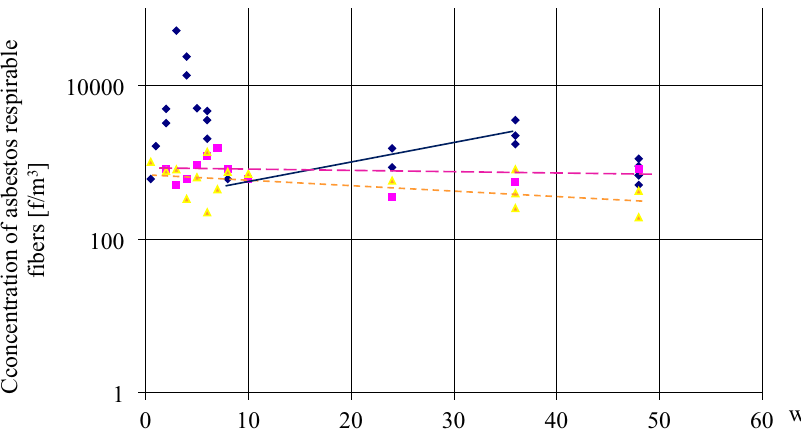
Figure 4. Changes in air pollution of three buildings “LIPSK” within 48 weeks. Dark blue diamond: Building (1) asbestos removal: Changes in asbestos dust concentrations from the commencement of asbestos dismantling, realization, and completion. During removal, dust leaked out of the work zone and increased its concentration during the first three weeks, up to the 5th week, up to 51,000 f/m 3 . The dark blue line indicates an increase in contamination that would not have been detected under the conditions of standard acceptance of the dismantling work and measurements immediately after the completed work. Pink square: Building (2), normal room operation. Yellow triangle: Building (3), normal room operation. After the tenth week of research, special operating rules were introduced in this building (room ventilation, wet mopping of surfaces, daily vacuuming with a HEPA filter, ACM marking, and prohibition of work that violates these products). The dotted orange line indicates a slight downward trend in